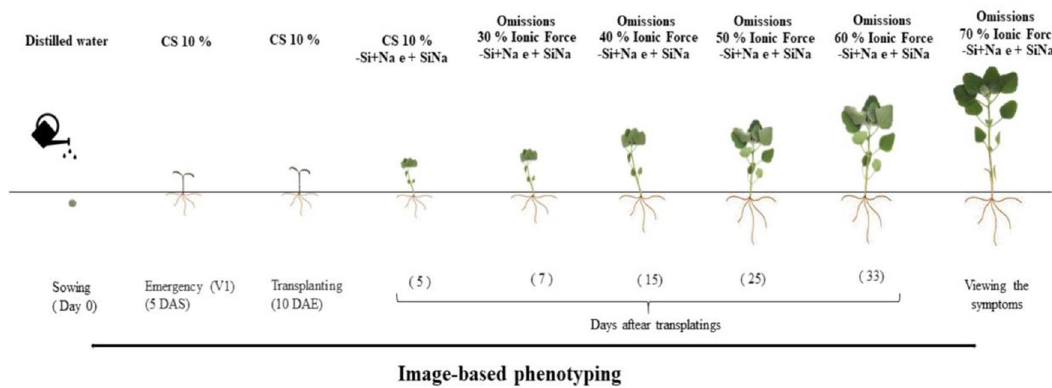
Figure 2. Schematic representation of the experimental project. After the seeds germinated, the seedlings were grown in different ionic forces of Hoagland solution (Hoagland and Arnon 23 ). CS complete solution, DAS days after sowing, DAE days after emergence. Software used to create this Figure was Microsoft Word (v1804, https:// www. micro soft. At 7 DAT, it was started nutrient omission in the nutrient solution and increased its concentration to 30% of that indicated by Hoagland and Arnon 23 for 7 days, then to 40% for 10 days, 50% for 8 days, 60% for 13 days, and 70% by the end of the experimental period. Once a week, the substrate was washed to avoid salinization. Deionized water was left to drain from the substrate, and the nutrient solution was applied again after 2 h. Phytosanitary treatments. For pest control, insecticide application (Thiamethoxam 141 g L −1 + Lamb- dacyhalothrin 106 g L −1 ) at a rate of 1.5 mL L −1 was performed at 38 DAT. Furthermore, acaricide applications (Fenpiroximato, 50 g L −1 and Abamectina, 18 g L −1 ) were performed twice a week from 40 DAT until the end of the experiment, at a rate of 1 mL L −1 . Green color index, photosystem II quantum efficiency, and pigment content. At 40 days of growing and 10 days from treatment application, the symptoms of N, P, K, and Mg limitation were character- ized at the tissue level. At 60 days of growing and 35 days from the treatment application, the symptoms of Ca limitation were characterized. As soon as the symptoms were characterized, physiological evaluations of the green color index (GCI), fluorescence and quantum efficiency of photosystem II (Fv/Fm), and chlorophyll and carotenoid contents were performed. The GCI and pigment content were measured in the fourth leaflet from the apex of the main stem. GCI was measured using a chlorophyllometer (Opti-Sciences, CCM-200), with five readings per plant. For pigment analysis, six leaf discs (6 mm) obtained from the middle third of the leaf limb were collected. The analyses were performed according to the methodology proposed by Lichtenthaler 25 using a Beckman DU 640 spectrophotometer at the following wavelengths: 663 nm for chlorophyll a, 647 nm for chlorophyll b, and 470 nm for carotenoids. Their contents were defined in relation to the fresh mass of each disc. The Fv/Fm was obtained from the chlorophyll fluorescence measurement using a fluorometer (Opti-Sciences, Os30P). The measurements were carried out between 7:30 a.m. and 9:30 a.m. using one plant per pot, and we measured the middle third of the plant, evaluating the fourth leaflet from the apex of the main stem. For this measurement, the sampled region was placed in the dark for adaptation at least 30 min before the excitation of the red-light pulse of 1 s. The evaluated parameters were F0 (minimum fluorescence for chlorophyll excitation) and Fm (maximum fluorescence for chlorophyll excitation). From these parameters, F0/Fm (basal quantum yield) and Fv/Fm (quantum efficiency of photosystem II) were obtained. The leaf area was also evaluated using the equipment Li-Cor model L1-3000 and was measured in cm 2 . Later, the leaves, stems, and roots were washed with water, detergent solution (Extran 0.1%), acid solution (HCl 0.1%), and deionized water, and then packed in paper bags and placed in dry conditions in a forced air circulation oven at 65 ± 5 °C until a constant mass was obtained. After drying, the samples were weighed on a precision scale (0.001) to obtain the shoot dry mass (leaves + stem) and root dry mass. Electrolyte leakage index. For determining the cellular leakage index, six leaf discs (6 mm) were removed from the middle third of the plant, which had new and fully developed leaves. The discs were packed in a beaker with 20 mL of deionized water at ambient temperature for 2 h. After this period, the initial electrical conductivity reading (EC1) was performed using a manual conductivity meter (TDS-3 digital measurer). Afterward, samples were taken to autoclave for 20 min at a temperature of 121 °C, and after cooling, a new conductivity reading was performed to determine the final conductivity (EC2). To estimate the leakage, the following formula 26 was used: EC1/EC2 × 100.